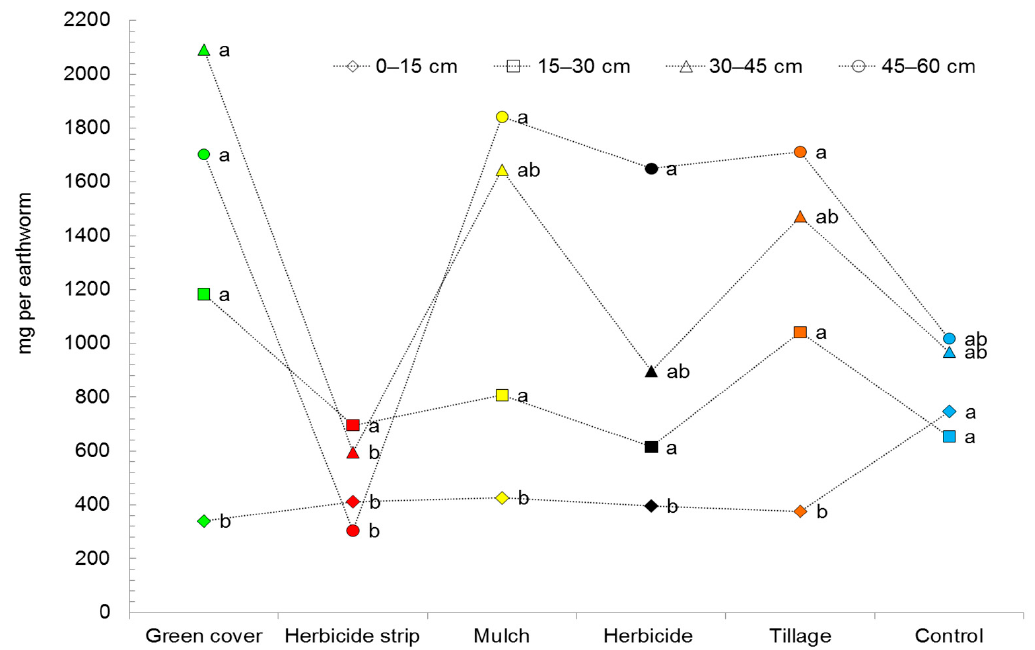
Figure 5. Mean biomass of individual adult earthworms per m 2 at different soil depths according to different soil management practices. Different letters denote significant differences among soil management practices in each depth ( p ≤ 0.05).